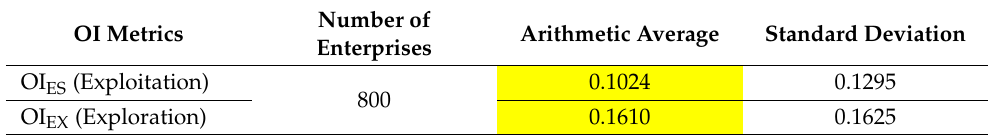
Table 7. Value of OI metrics for the verification of H1 ( p = 0.00026 < 0.05).